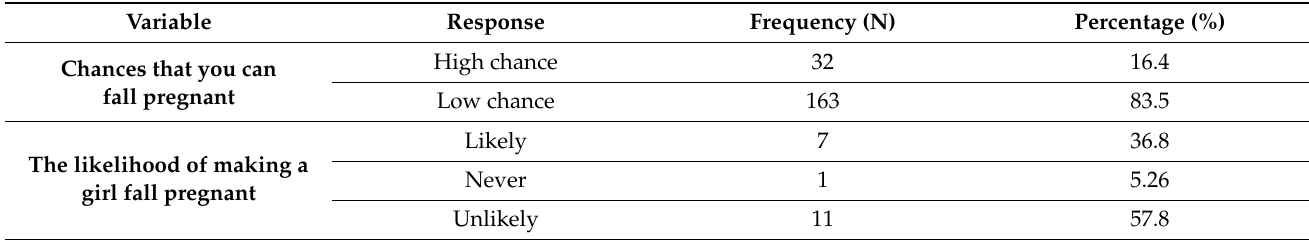
Table 6. Response of the participants concerning pregnancy (n = 219).